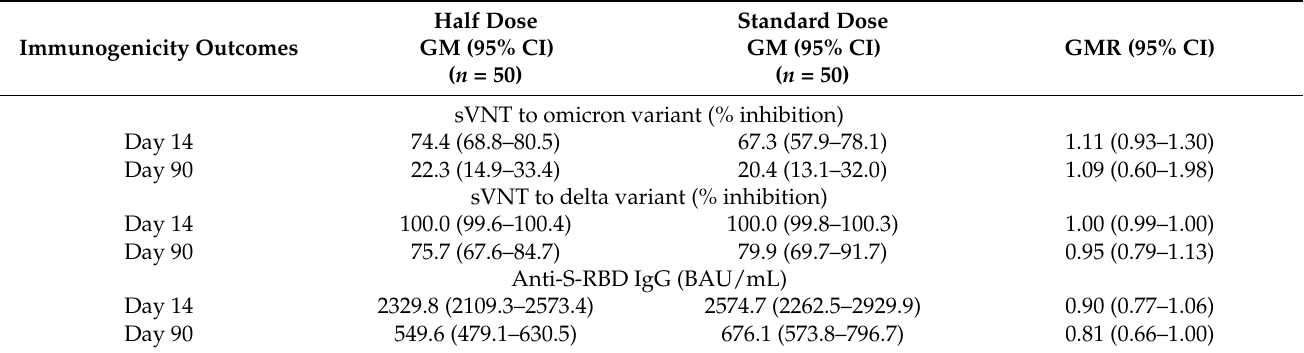
Table 2. Results of sVNT for variants of concern and anti-S-RBD IgG at day 14 and day 90 among adults who received half-dose or standard-dose BNT162b2 booster.